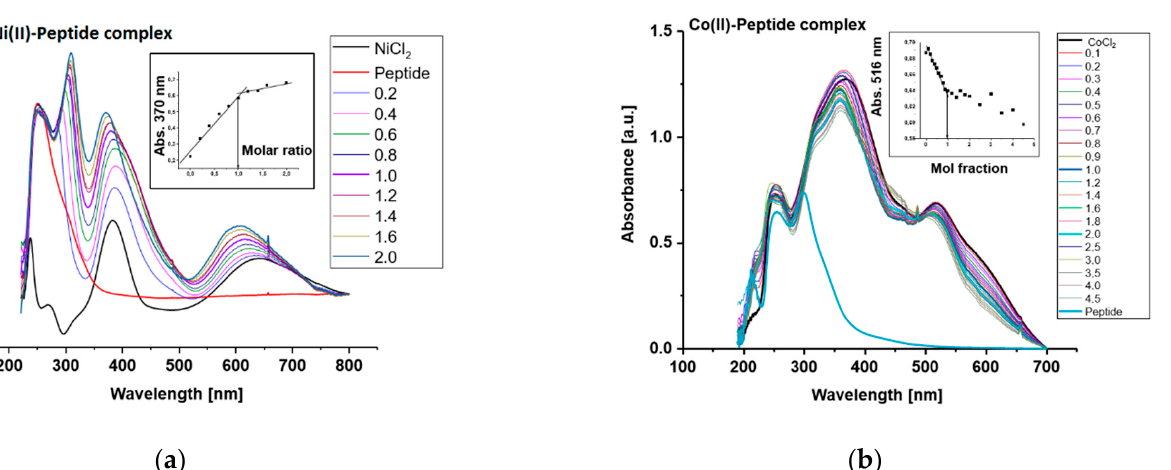
Figure 1. UV/VIS absorption spectra and Job plots of different molar ratios of ( a ) the cyclic nickel- binding peptide CNAKHHPRCGGG with Ni 2+ ions and ( b ) the cyclic cobalt-binding peptide CTQMLGQLCGGG with Co 2+ ions. All reactants were dissolved in 11.69 g/L NaCl, pH 7.4.